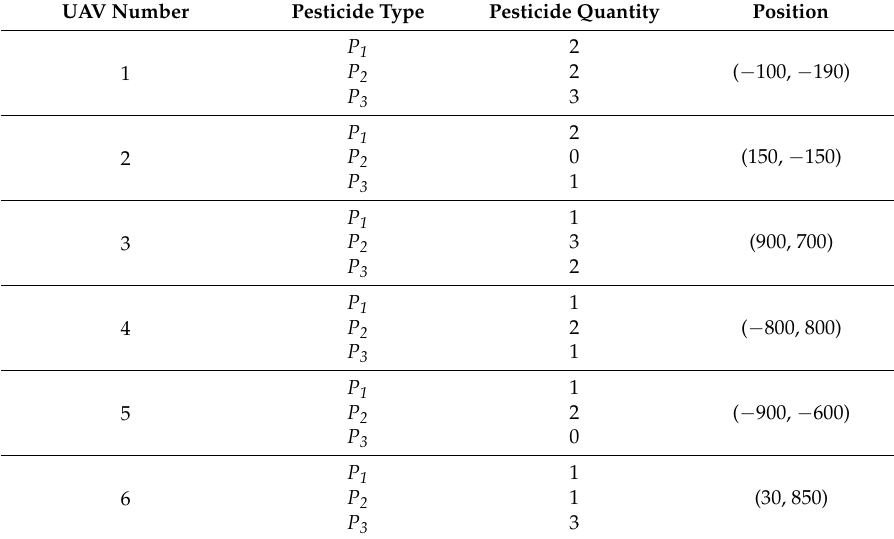
Table 4. Loading detail of six UAVs.